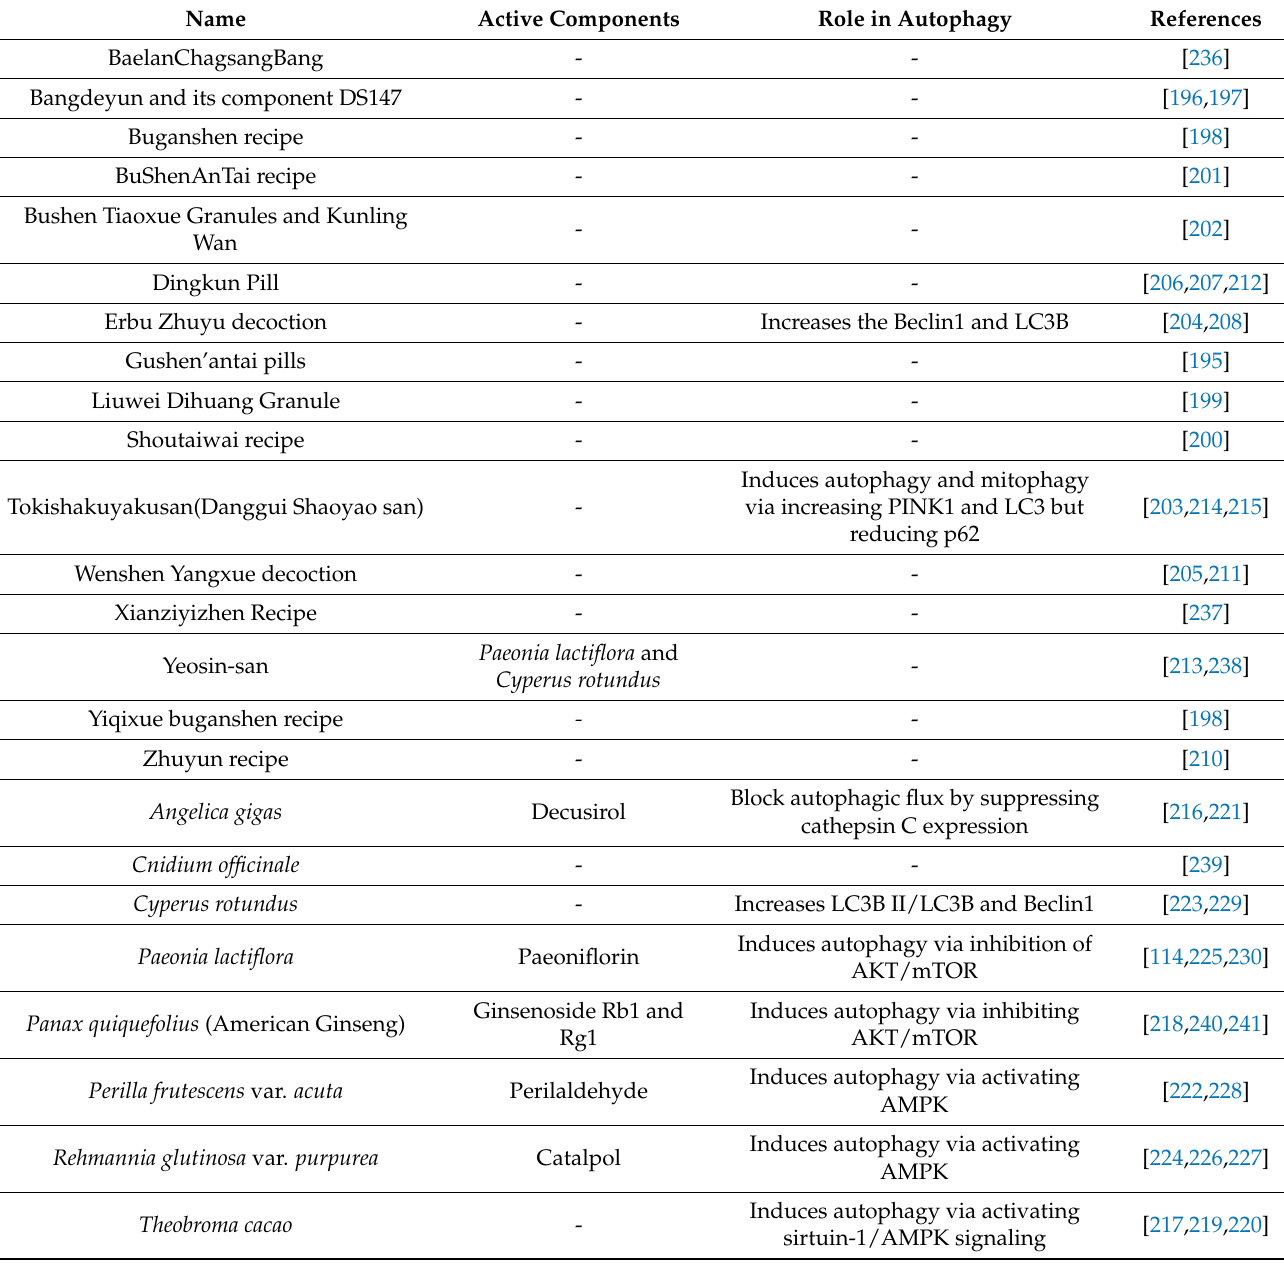
Table 2. Effect of traditional herbal medicines improving endometrial receptivity on